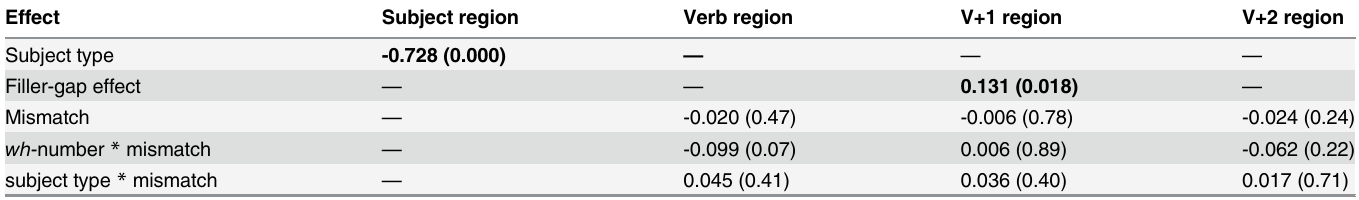
Table 7. Estimates and (p-values) for laboratory replication of Experiment 1. Bold font indicates a signi fi cant result.